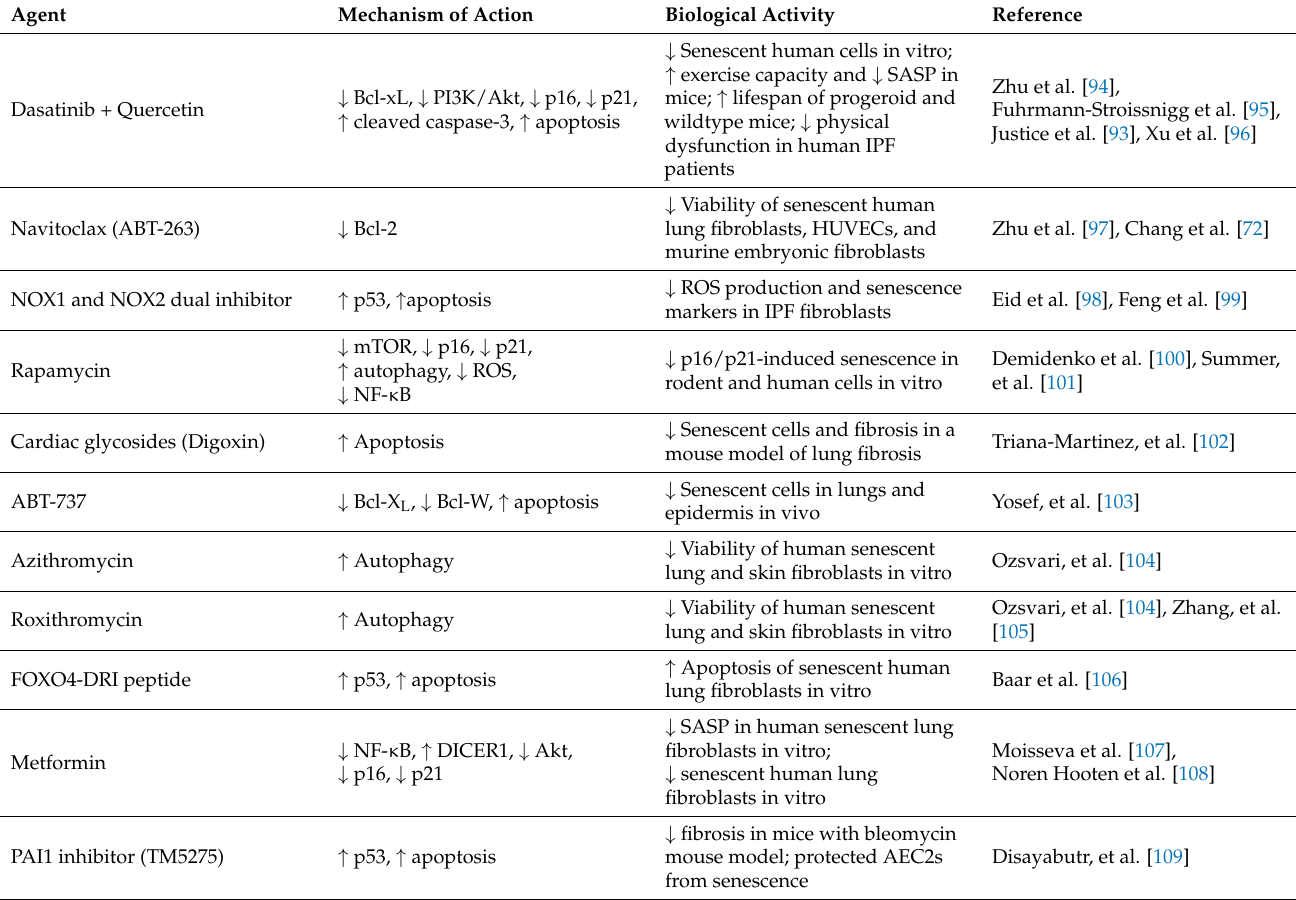
Table 1. Senescence-targeted treatments with emerging evidence in pulmonary